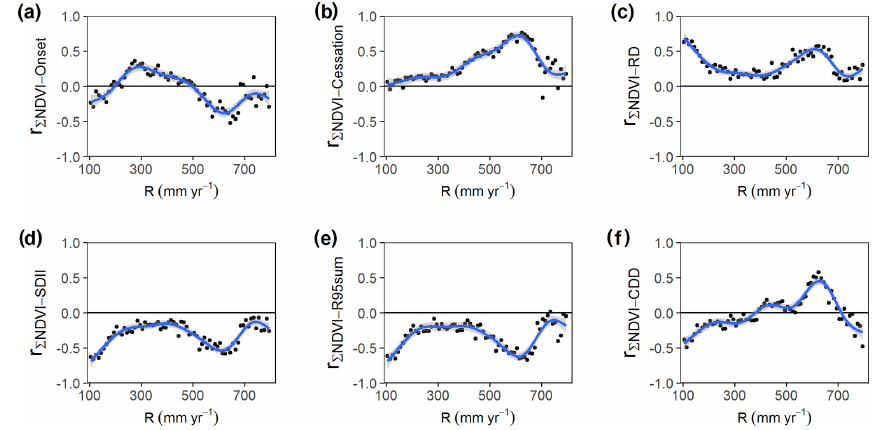
Figure 7. Effects of seasonal-rainfall metrics on growing season ANPP as a function of seasonal rainfall amount. The non-parametric Spearman’s rank correlation between growing season ANPP and rainfall metrics are shown for each 10mm interval. The lines are GAM fitting curves, and shading represents the 95% confidence intervals of the fitting.